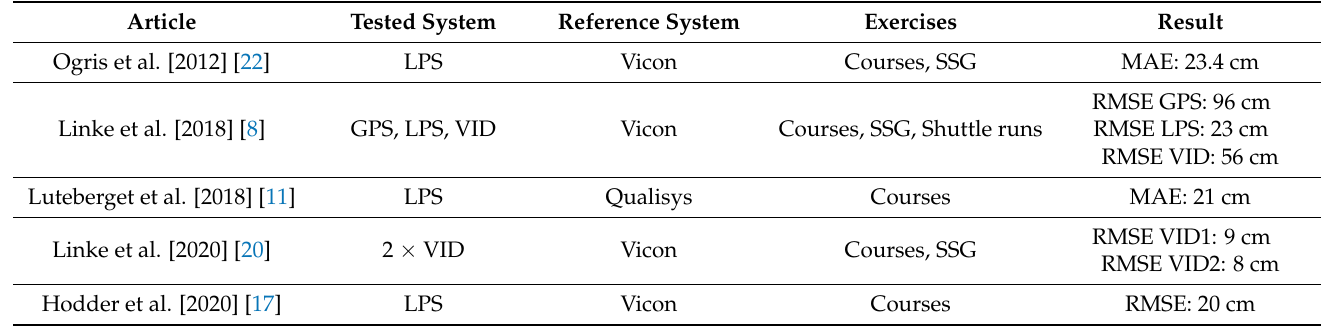
Table 7. Results from studies using similar validation